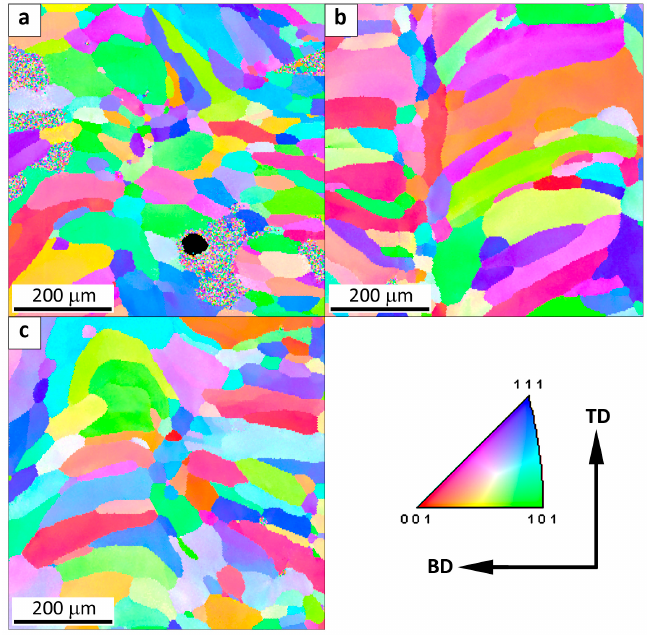
Figure 6. The map of crystallographic orientation in a sample obtained at a high cooling rate: ( a ) at the substrate (2.3 × 10 4 K/s), ( b ) half the height of the sample (3.5 × 10 4 K/s), and ( c ) top of the sample (2.6 × 10 4 K/s). The spatial orientation of the sample is presented with respect to the building direction (BD) and transverse direction (TD).